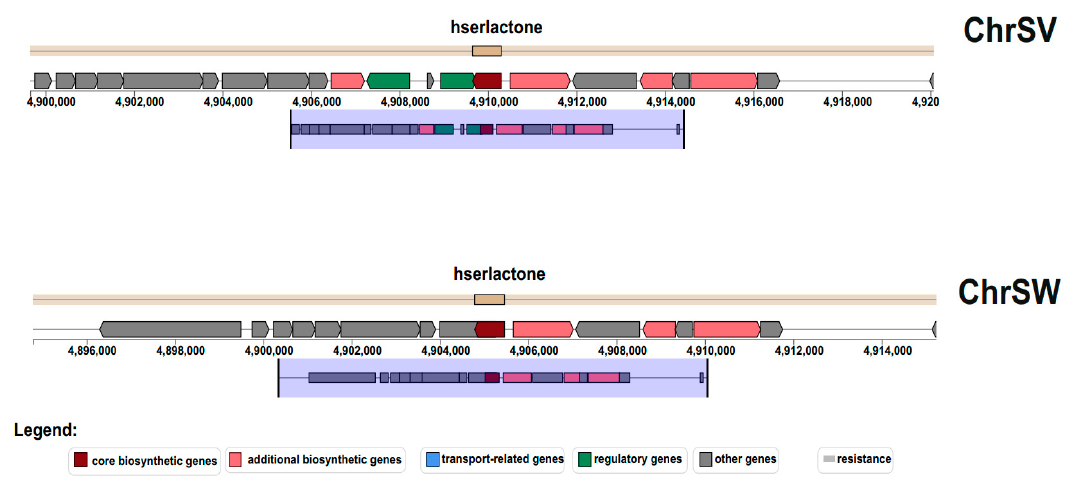
Figure 3. Biosynthetic gene cluster for homoserine lactone in natural pigmented (ChrSV) and unpigmented (ChrSW) isolate of C. vaccinii. The resource antiSMASH v.5.1.2 was used for prediction. Lack of luxR expression due to deletion in the genome of the ChrSW strain resulted in insensitivity to external AHL and inability to increase the expression of endogenous AHL synthase LuxI, so all underlying modulation of gene expression remains intact, including expression of the vioABCDE operon (Figure 4A). A clear pattern of unpigmented cells in a mixed (equal mix of pigmented and unpigmented isolates) colony biofilm model confirmed the inability of the Δ luxR mutant to respond through the AHL-LuxI/LuxR pathway (Figure 4B).